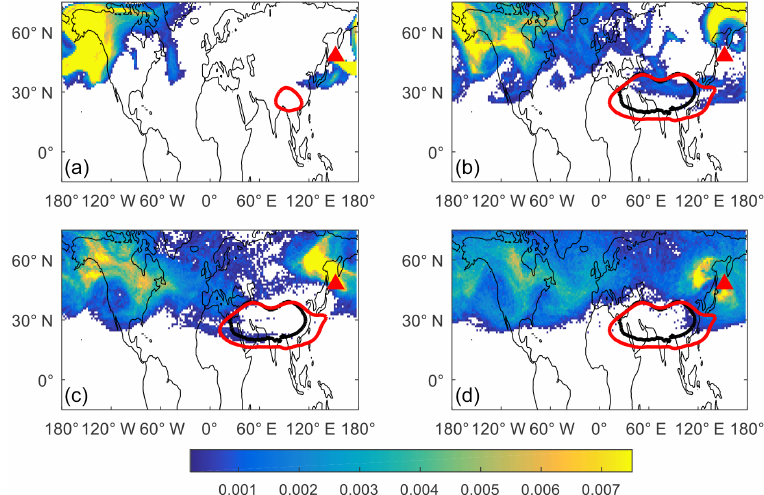
Figure 10. Same as Fig. 8 but for percentage (%) of total air parcels above the 400K isentropic surface.